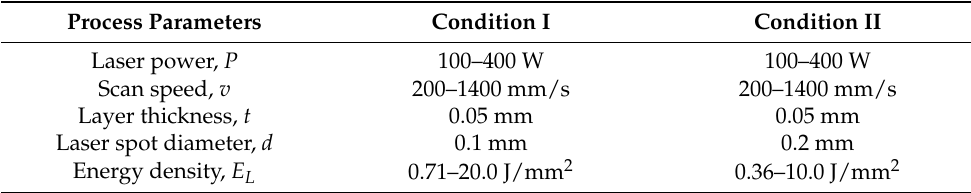
Table 2. Fabrication conditions of single